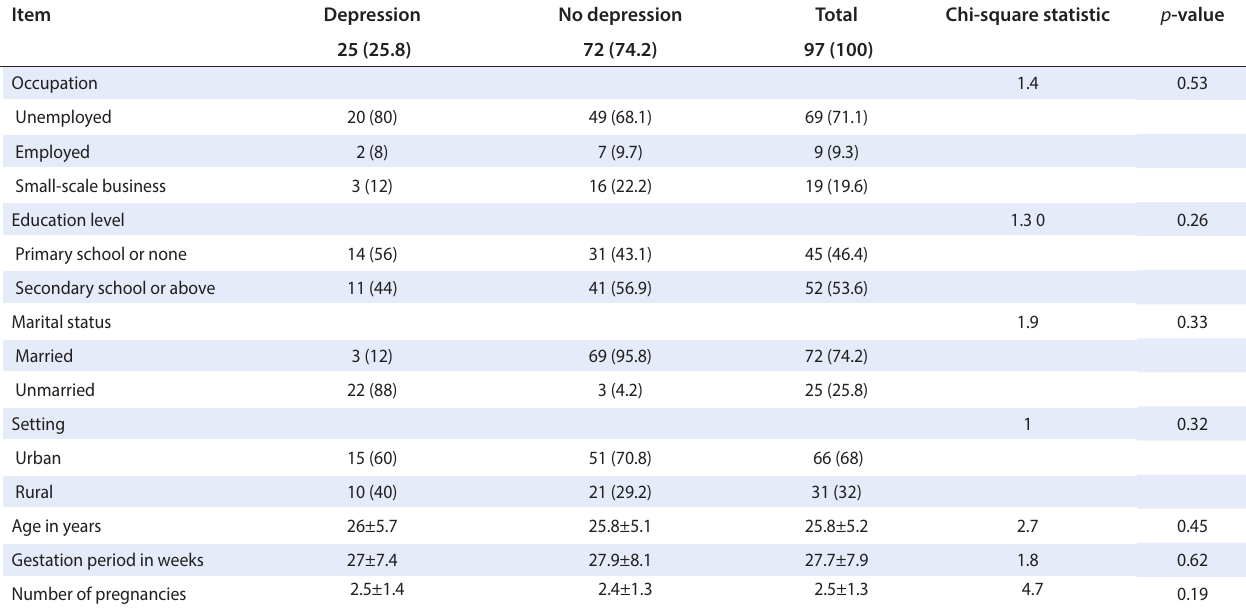
Table 1: Relationship between demographic characteristics of respondents and depression